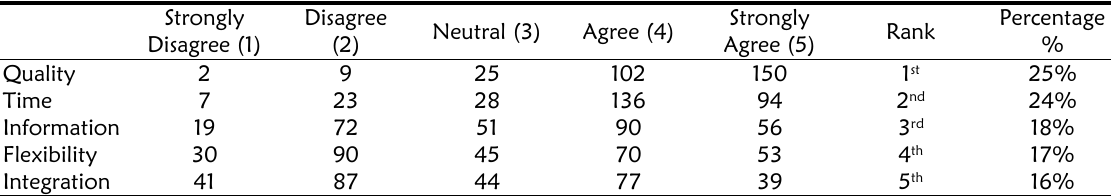
Table 2: Ranking of Likert